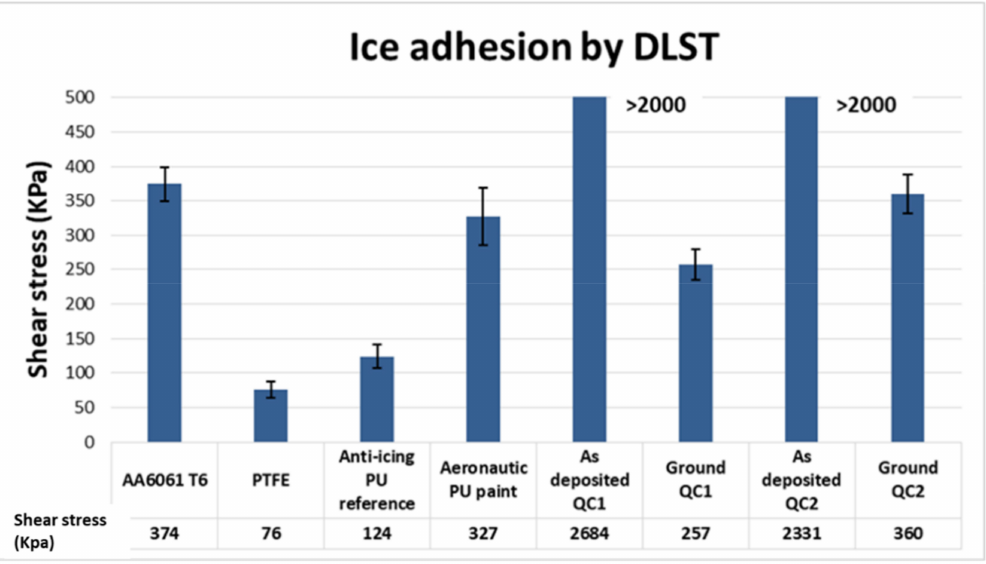
Figure 19. Ice adhesion